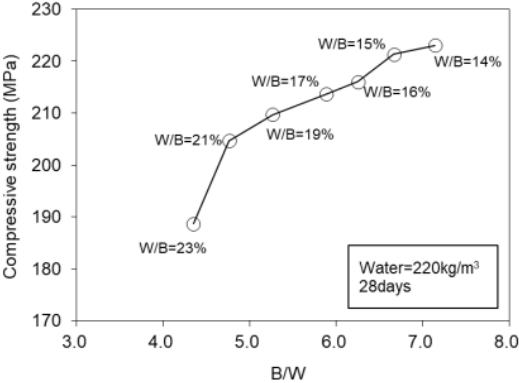
Figure 14. Compressive strengths varied by various W/B mortar.